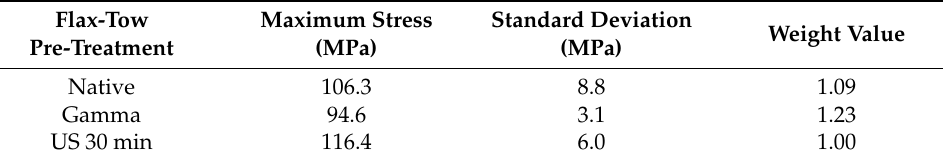
Table 5. Maximum stress values of PLA composite reinforced by respective flax-tows and corre- sponding weight values of scutching native and pre-treated flax tows by Gamma and US 30 min.